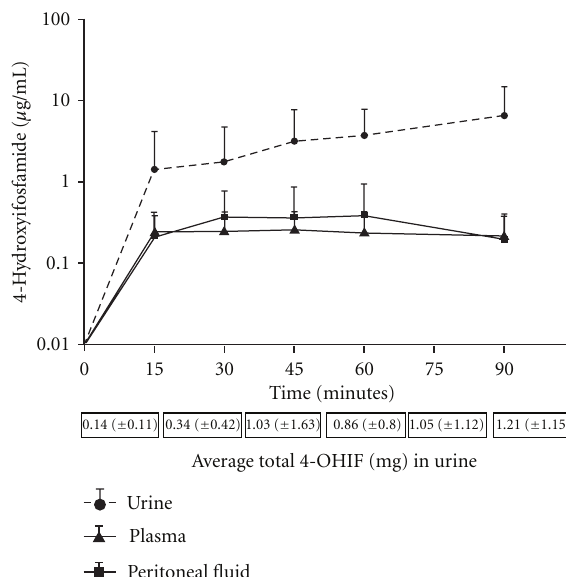
Figure 2: Plasma, peritoneal fluid, and urine concentrations of 4- hydroxyifosfamide over a 90-minute infusion. The total quantity of 4-hydroxyifosfamide in mg excreted in the urine is presented at the bottom.